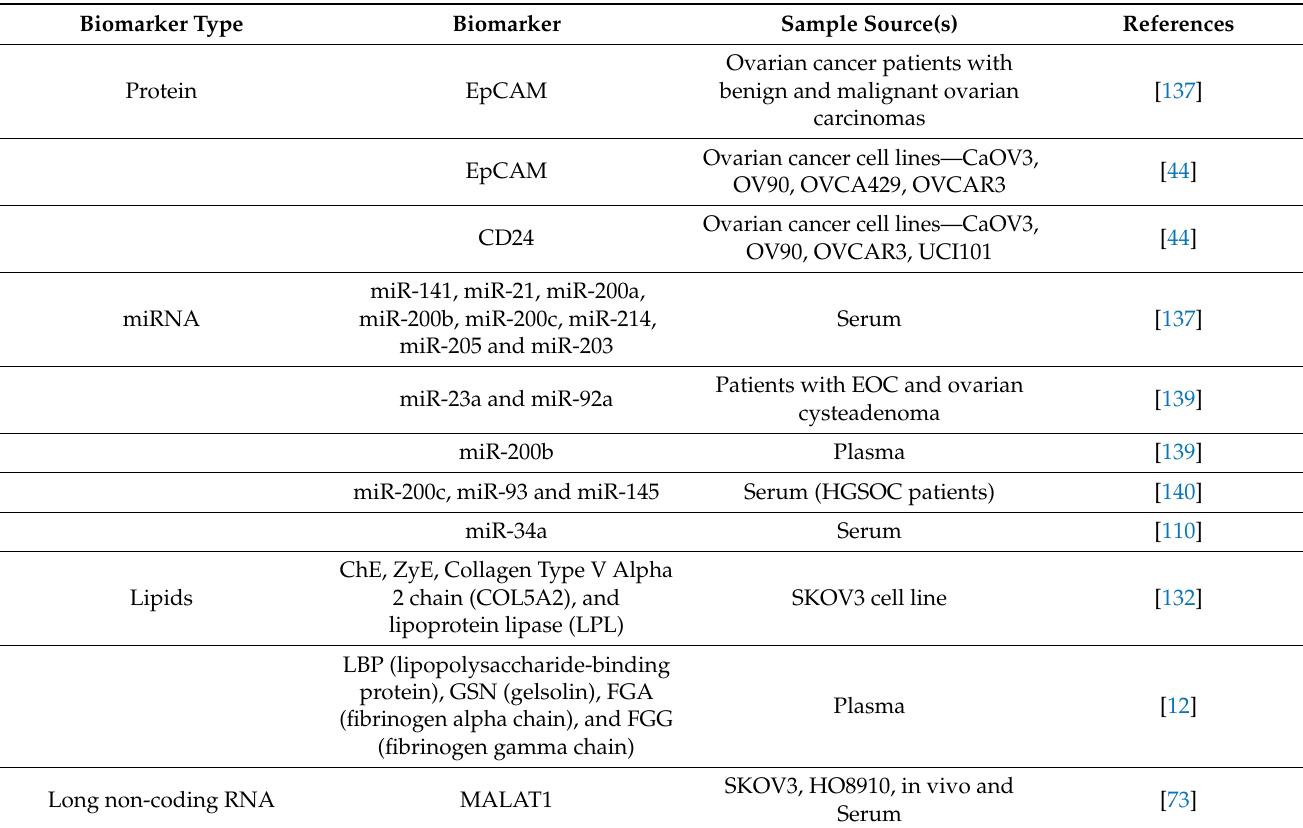
Table 1. Lists of EV biomarkers and their